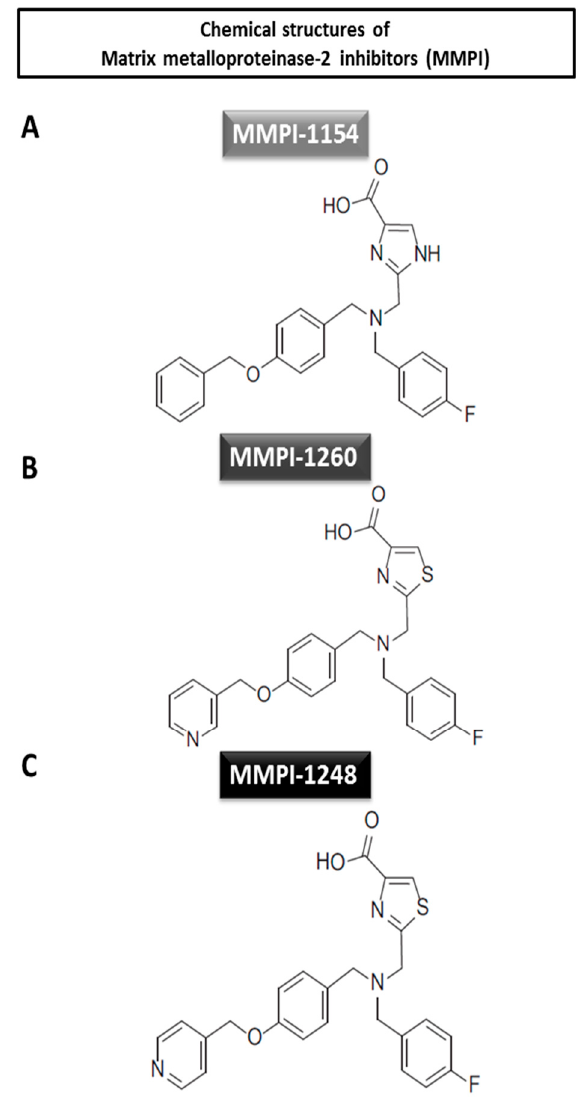
Figure 1. Chemical structures of the tested matrix metalloproteinase-2 inhibitors. ( A ) Imidazole-4-carboxylic acid derivate and ( B and C ) thiazole-4-carboxylic acid derivates.